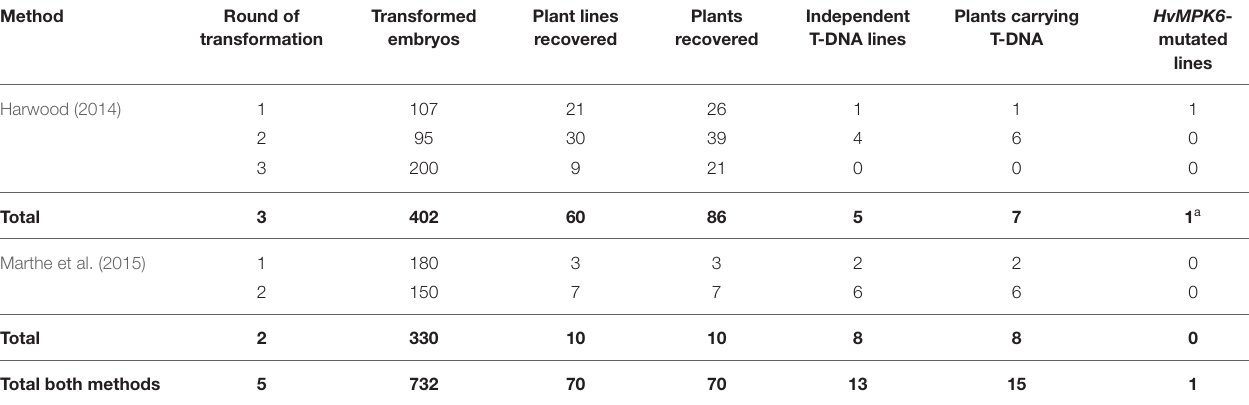
TABLE 1 | Overview of the transformation experiments, T0 generation recovery, and genotyping results. Method Round of